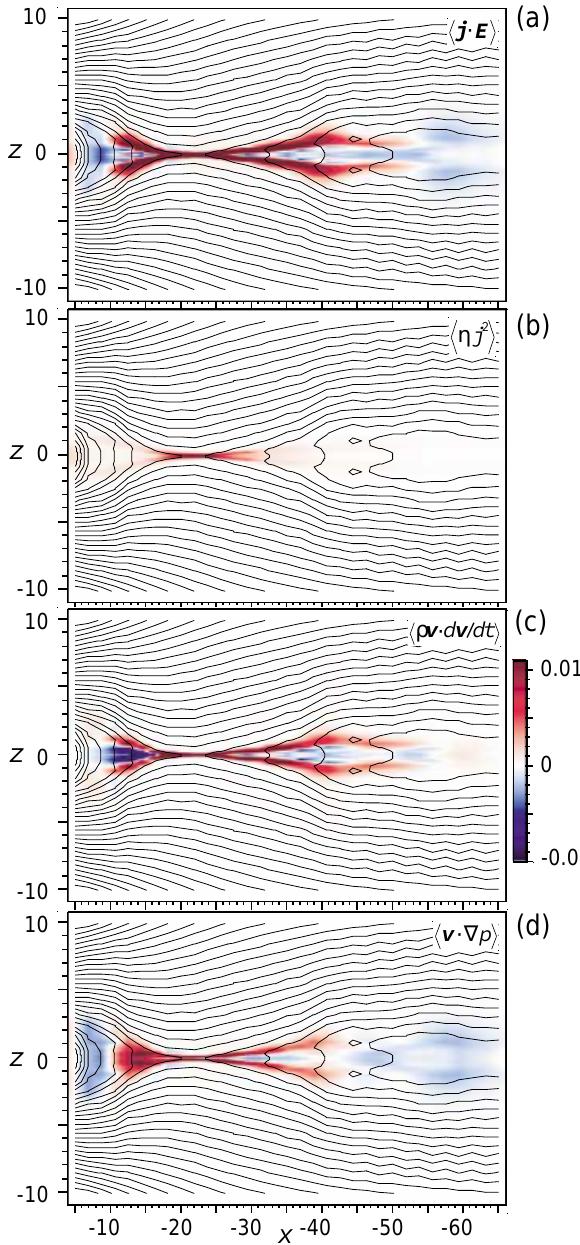
Fig. 5. Energy transfer terms, integrated over y : (a) j · E , (b) ohmic heating ηj 2 , (c) kinetic energy transfer ρv · d v /dt , (d) transfer be- tween kinetic and thermal energy v · ∇ p